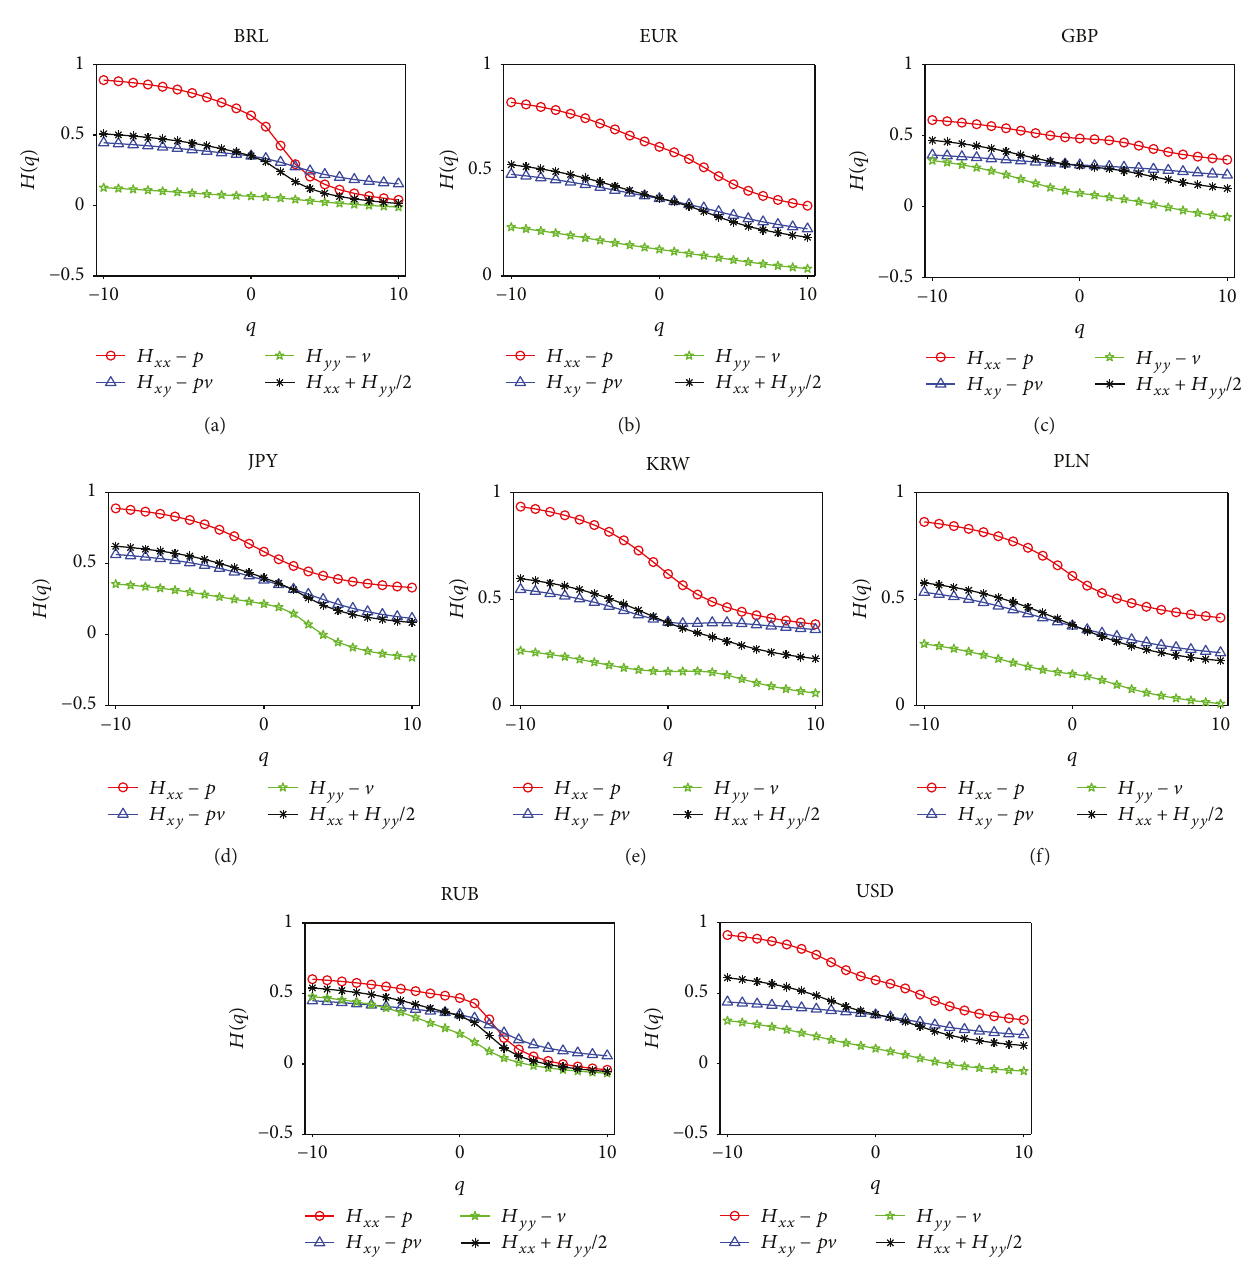
Figure 6: The generalized Hurst exponent values of H